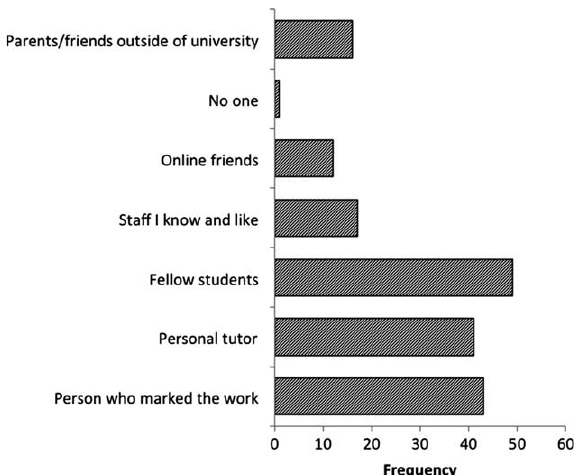
Figure 3. The students’ sharing of feedback.